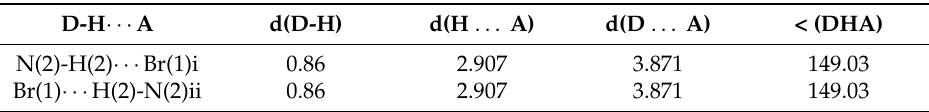
Figure 5. Part of the packing diagram of 1 showing the formation of intramolecular hydrogen bonding and C-H . . . π interaction. C g stands for the centroid of the ring. Table 3. Hydrogen bond geometry (Å, °) for crystal 1 .